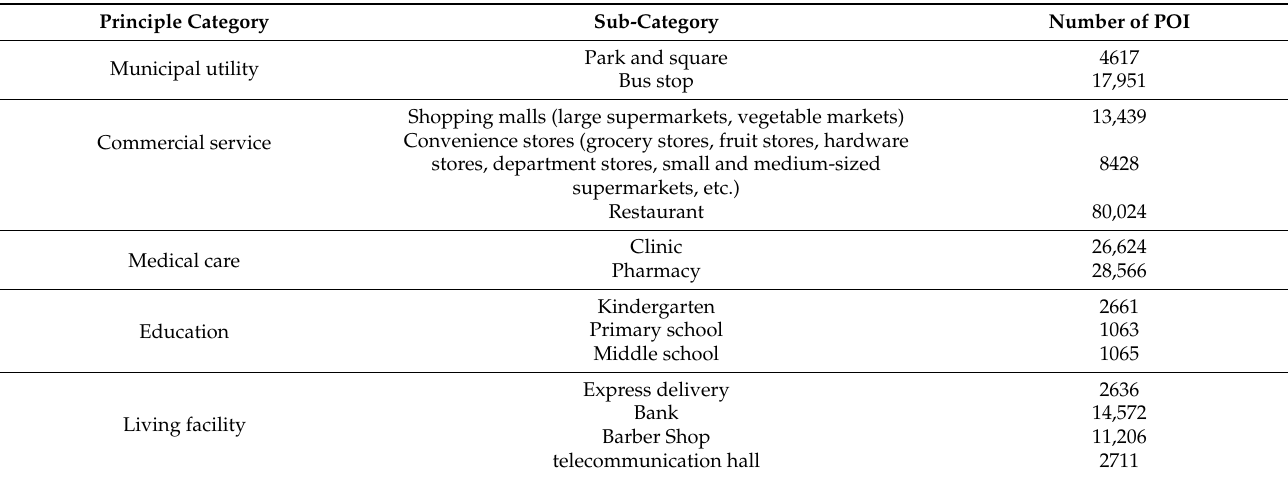
Table 1. Facility classification table for walkability calculation.